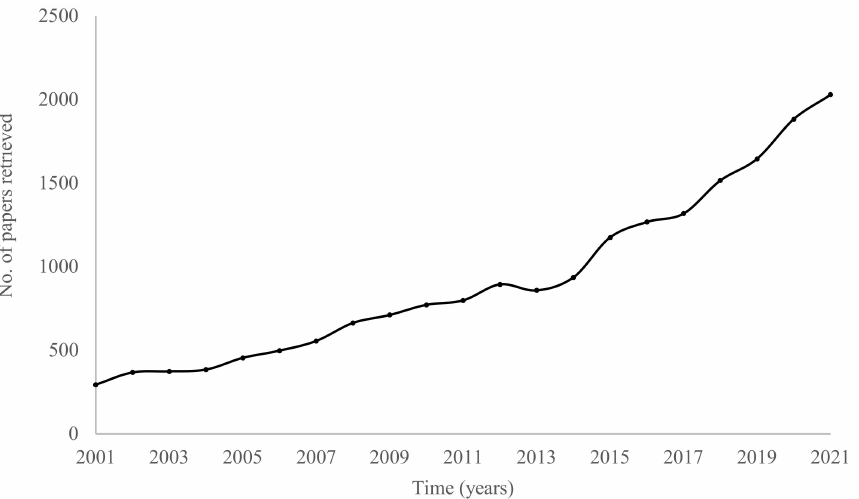
Figure 1. Numbers of papers retrieved in a search on the Web of Science using the terms “lactic acid bacteria” and